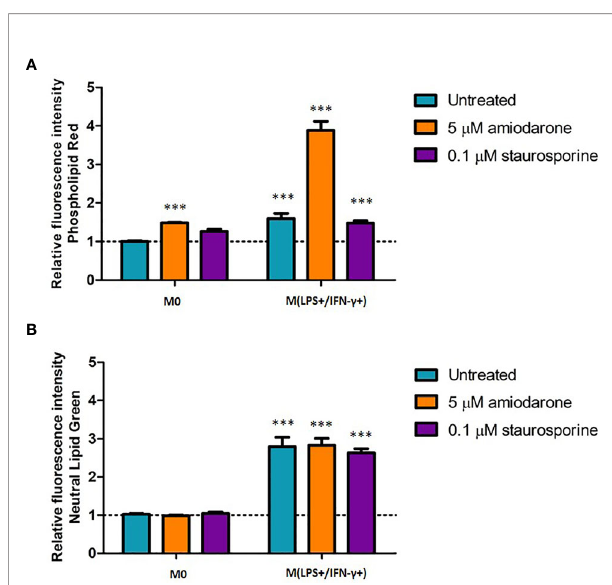
FIGURE 8 | Phospholipid (A) and neutral lipid (B) content in M0-non- activated, LPS/IFN- g and IL-4 activated NR8383 rat macrophages after 24 h exposure to 5 µM amiodarone (orange bars) and 0.1 µM staurosporine (purple bars). Data are normalized to cell count and presented as mean values ± SEM of three separate experiments. Statistical comparisons are made using a one-way ANOVA analysis with Bonferroni ’ s multiple comparison post-hoc test. Results are compared to non-polarized control (M0); *** indicates p < 0.001.